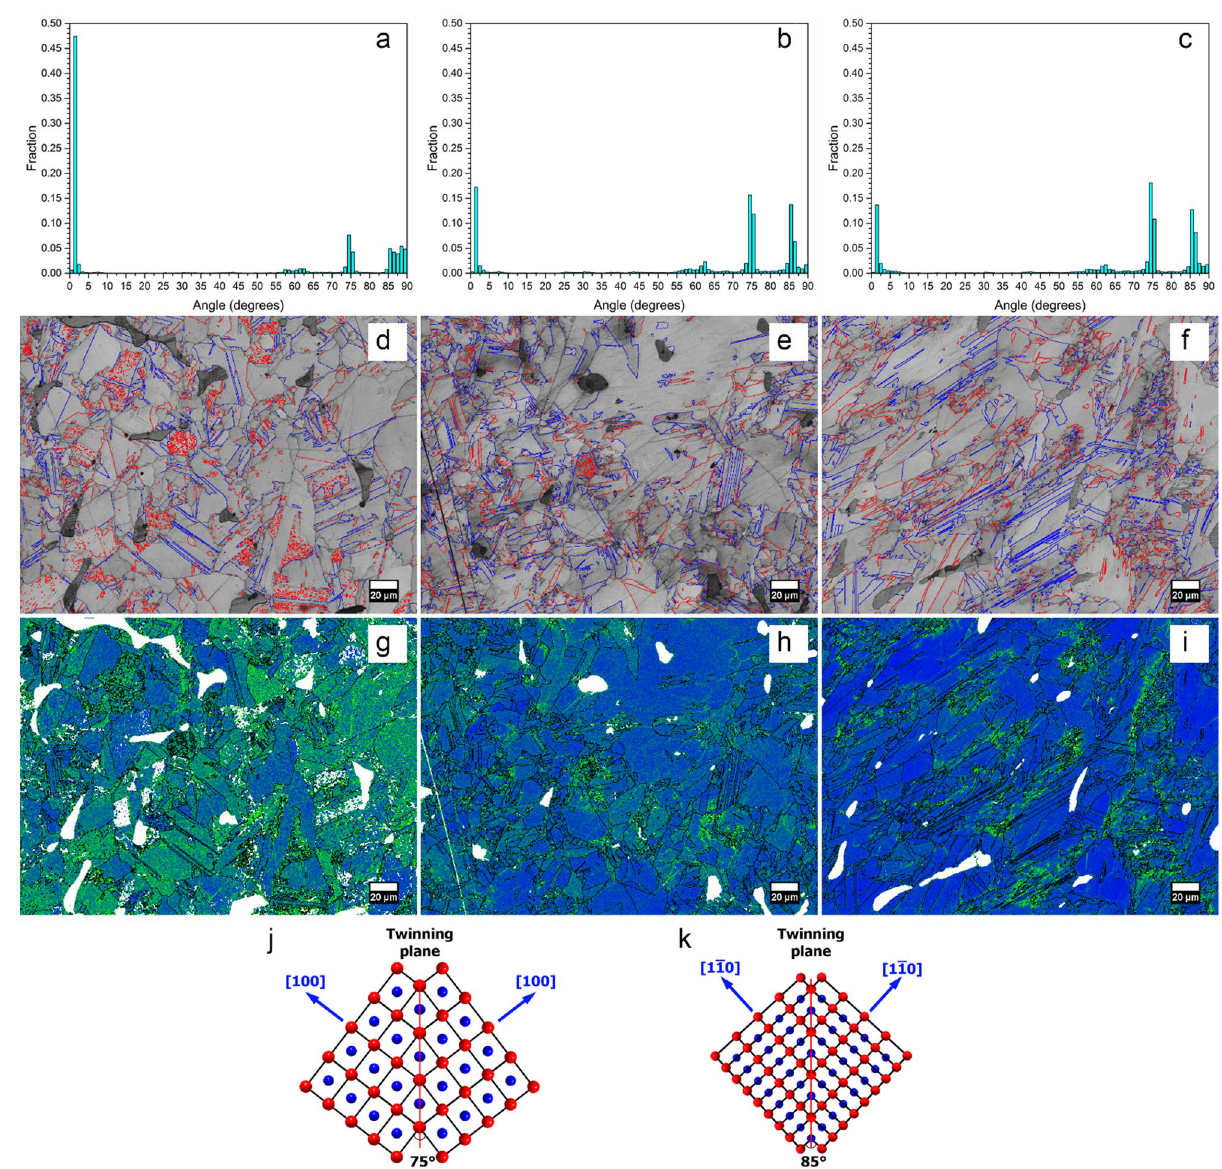
Figure 4. (a–c) show the grain boundary distribution for the Mn 55 Al 45 C 2 , Mn 55 Al 45 C 2 (VC) 0.5 and Mn 55 Al 45 C(VC) 1 samples and (d–f) show the corresponding <100> 75˚ and <110> 85˚ twins in red and blue. (g–i) show the local misorientation for the Mn 55 Al 45 C 2 , Mn 55 Al 45 C 2 (VC) 0.5 and Mn 55 Al 45 C(VC) 1 samples. (j,k) illustrate the <100> 75° and <110> 85° twin boundaries, respectively. For simplicity, an atomic ratio of Al:Mn = 1:1 was assumed; red atoms (corners) are Al while blue atoms (center) are